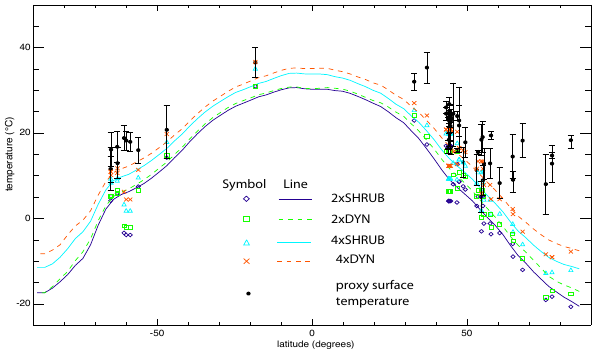
Fig. 4. Zonal mean annual SSTs for 2 × SHRUB (dark-blue dia- monds), 2 × DYN (green squares), 4 × SHRUB (light-blue trian- gles) and 4 × DYN (orange crosses). The black dots show the ter- restrial temperatures indicated by proxy data with error bars (the smaller black dots indicate early Eocene climatic optimum temper- atures). The coloured shapes show the temperature at the same lat- itude and longitude as the location of the data as predicted by each model. The lines show the modelled latitudinal temperature gradi- ents for each simulation. Data set from Lunt et al. (2012).